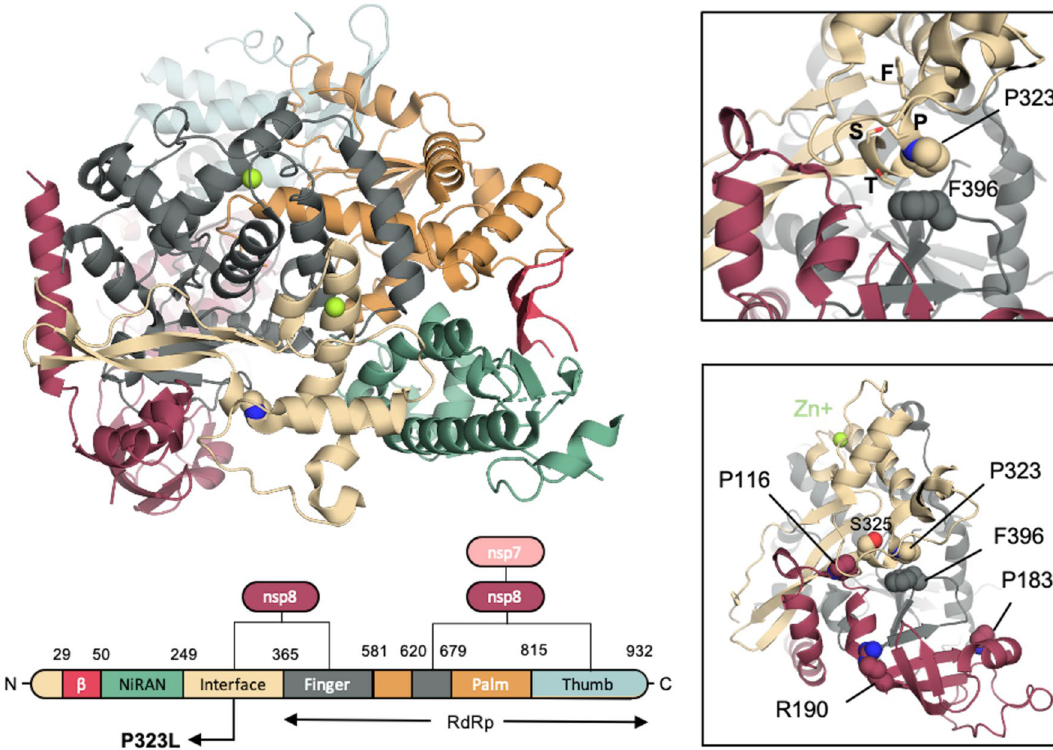
Figure 8. Structural implications of the D614G mutation in S-protein. ( a ) Domain organisation of SARS- CoV-2 nsp12 in complex with nsp7 and nsp8 cofactors. The P323 is depicted in beige spheres. ( b ) Close up around P323. The residues of the 321 FP P TS 325 stretch are depicted in sticks, while F396 that P323 interacts with is depicted in spheres. ( c ) Residues P116, P183 and R190 of the nsp8 that has been reported to be crucial for the nsp8/nsp12 interaction in SAR-CoV-1 are depicted in red